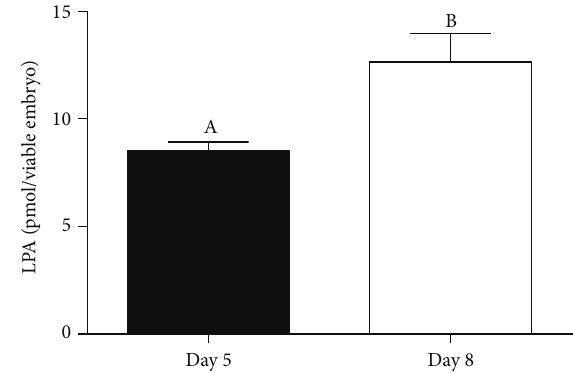
Figure 3: LPA production by late cleavage (Day 5) and blastocyst (Day 8) stage bovine in vitro produced embryos. LPA concentrations represent theaccumulated production sinceDay 2 and areexpressed as pmol/viable embryo. Columns with different superscripts differ significantly: AB, 𝑃 < 0.05